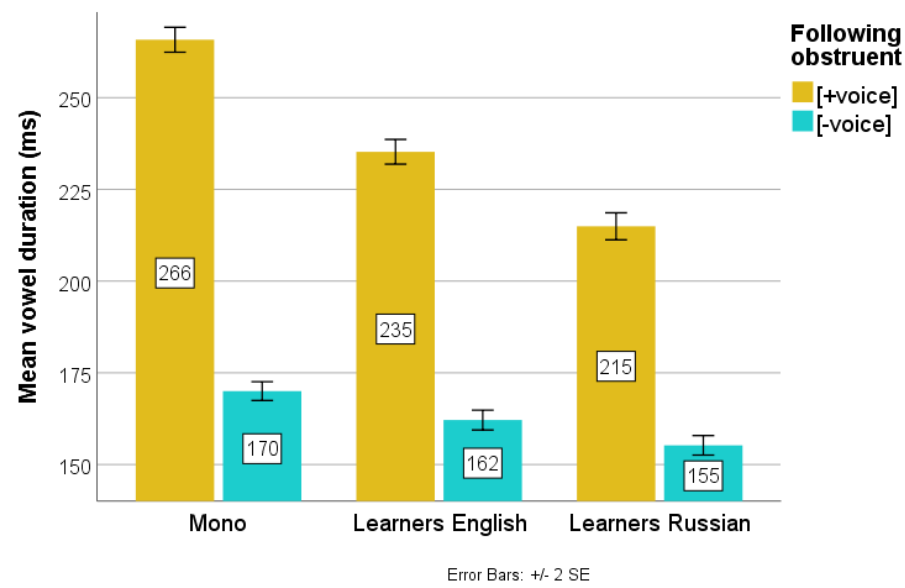
Figure 15. Mean vowel duration before voiced and voiceless obstruents in monolingual controls’ and learners’ English; learners’ Russian productions are provided for comparison.